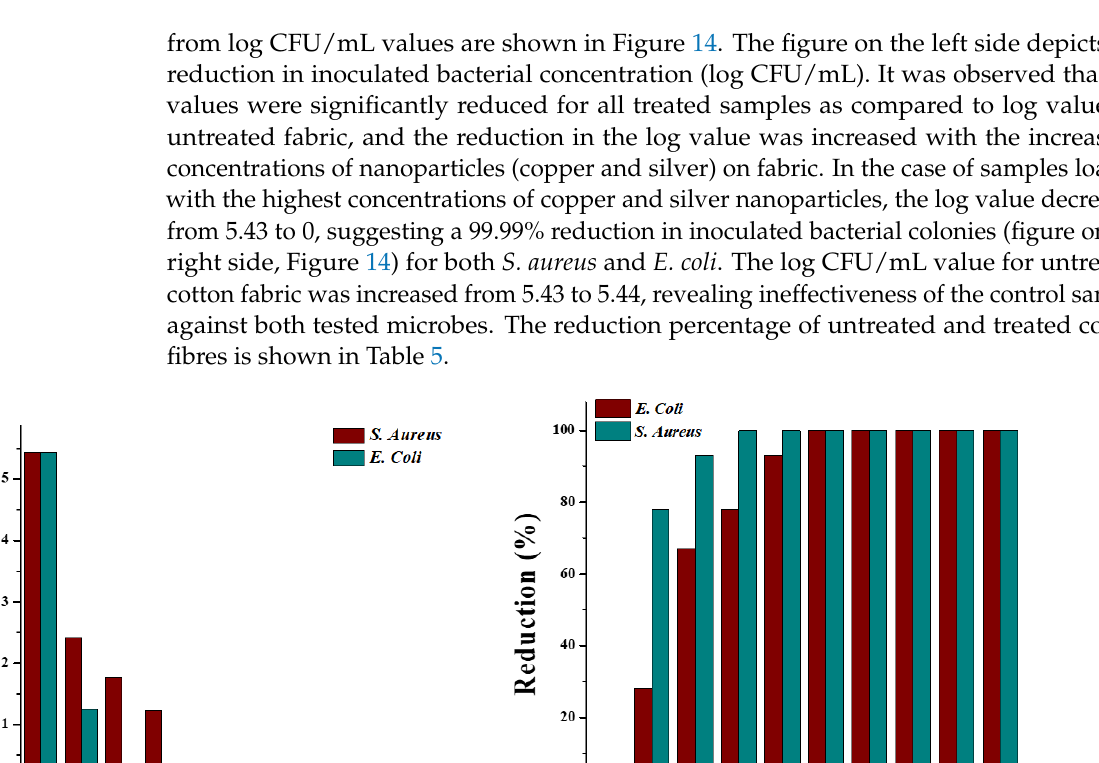
Table 5. Reduction percentage of untreated and treated cotton fibres.